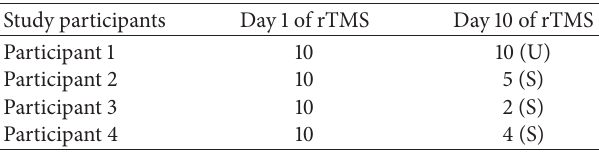
Table 1: Distribution of the Hallucination Change Score (HCS) obtained from patient’s chart